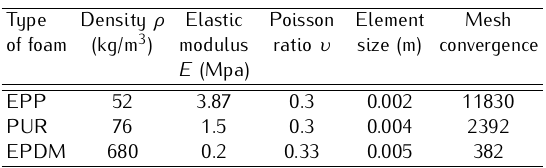
Table 3. Description of the material and element properties of the finite element modeling